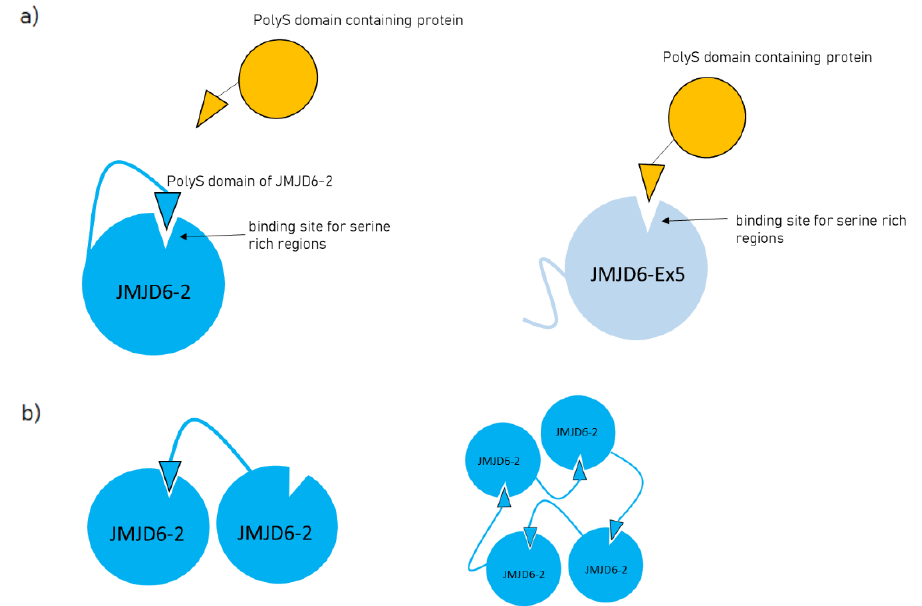
Figure 7. Proposed model of a polyS-domain binding site within JMJD6. ( a ) JMJD6-2 possesses a polyS domain in the C-terminal region and interacts with its own polyS binding site, thereby blocking interaction with other polyS domain-containing proteins. In contrast, JMJD6-Ex5 does not have its own polyS domain, allowing interaction with other polyS domain-containing proteins. ( b ) Interaction of JMJD6-2 to its own polyS binding site could be intermolecular and supporting oligomerization of JMJD6-2.